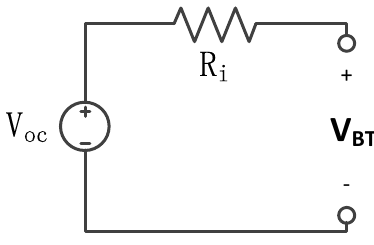
Figure 4. Rint model of the battery.